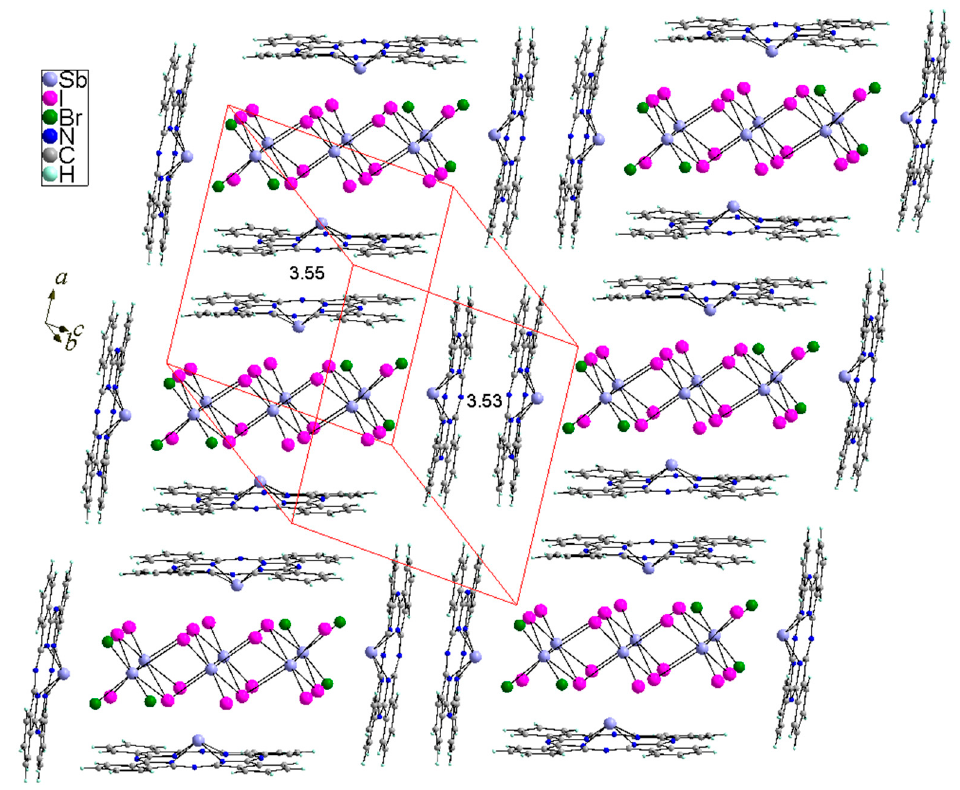
Figure 4. Packing of [(SbPc) 4 (Sb 6 I 16 Br 6 )] showing a stacking structure in 1 .